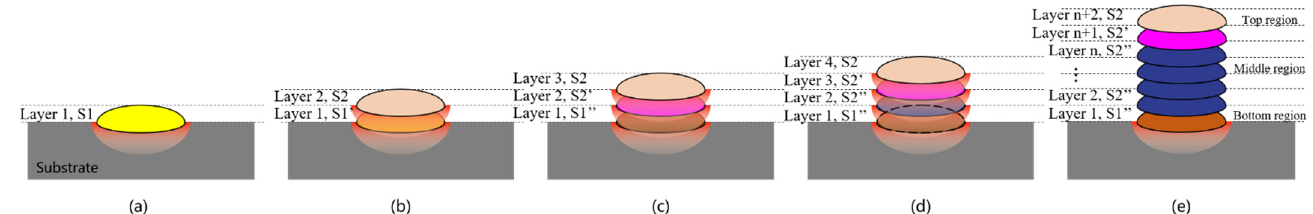
Figure 2. Schematic showing the structural evolution process of the LMD multilayer printing: ( a – d ) represent the solidified structure of the cladding layers by 1,2,3,4 printing, respectively; ( e ) represents the overall solidified structure of the cladding layers by n + 2 printing.